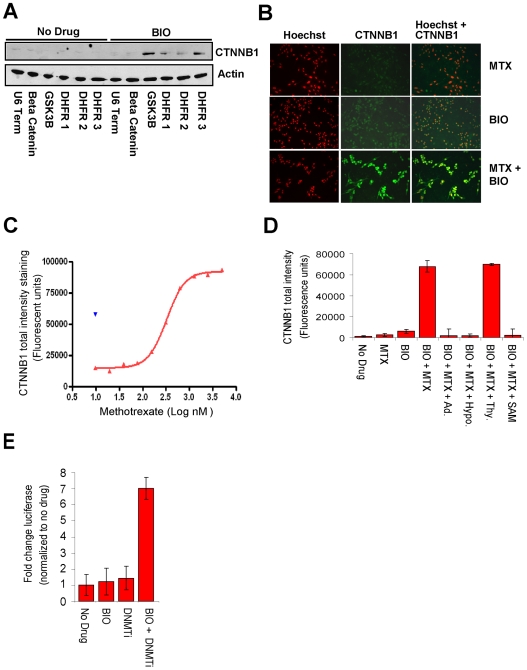
DHFR inhibition synergizes with BIO to increase intracellular β-catenin protein accumulation.(A) RKO-BAR cells were transduced with a lentiviral vector control lacking an shRNA (U6-TERM), with vectors encoding shRNAs targeting β-catenin or GSK3β, or with vectors encoding three distinct shRNAs targeting DHFR and then exposed to BIO (right lanes) or vehicle control (left lanes) 48 hours following transduction. Protein lysates were harvested and subjected to Western Blot analysis with a β-catenin specific antibody. Whereas none of the vectors had an effect in the absence of drug, silencing of GSK3β or DHFR synergized with BIO to induce accumulation of β-catenin (CTNNB1, blot is representative of three separate experiments). (B) RKO-BAR cells were exposed to methotrexate (MTX), BIO (312 nM), or the combination of the two drugs and stained with the nuclear dye Hoechst and with an antibody recognizing β-catenin. Images were collected on an InCELL 1000 high content imager. A synergistic increase in β-catenin expression and nuclear localization was observed upon dual inhibition of GSK3 and DHFR. (C) RKO-BAR cells were exposed to a titration of methotrexate in the presence of 312 nM BIO and stained for β-catenin. β-catenin expression was quantified on an Acumen Explorer laser scanning microplate reader. As shown in the graph, a methotrexate dose-dependent increase in β-catenin levels was observed (red curve, each point represents the average of six replicate samples). The effect of a BAR-activating dose of BIO alone (1 µM) is provided as a reference (blue). (D) RKO-BAR cells were subjected to DHFR, GSK3 (BIO 312 nM), or dual inhibition in the absence or presence of products of the folate metabolism pathway. β-catenin accumulation was analyzed as in panel C. Data represent the mean and standard deviation (SD) of 8 replicate wells for each sample. Addition of purines (adenosine, Ad., or hypoxanthine, Hypo.) or s-adenosylmethionine (SAM), but not thymidine (Thy.) blocked the synergistic effect of dual inhibition. (E) RKO-BAR cells were subjected to DNMT inhibition (DNMTi) with 5′ Aza-2′-deoxycytidine (750 nM), BIO (312 nM), or both inhibitors in combination. Luciferase activity was measured 16 h following drug addition. Data represent the mean±SD of 4 replicate wells for each sample.